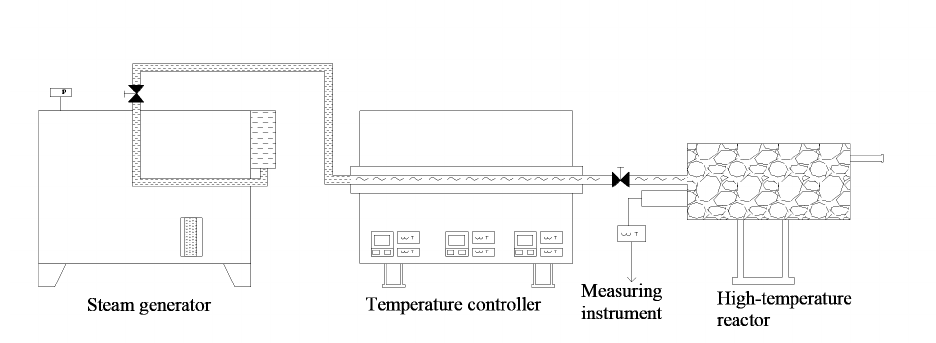
Fig. 1. Test system for oil shale pyrolysis with water vapour